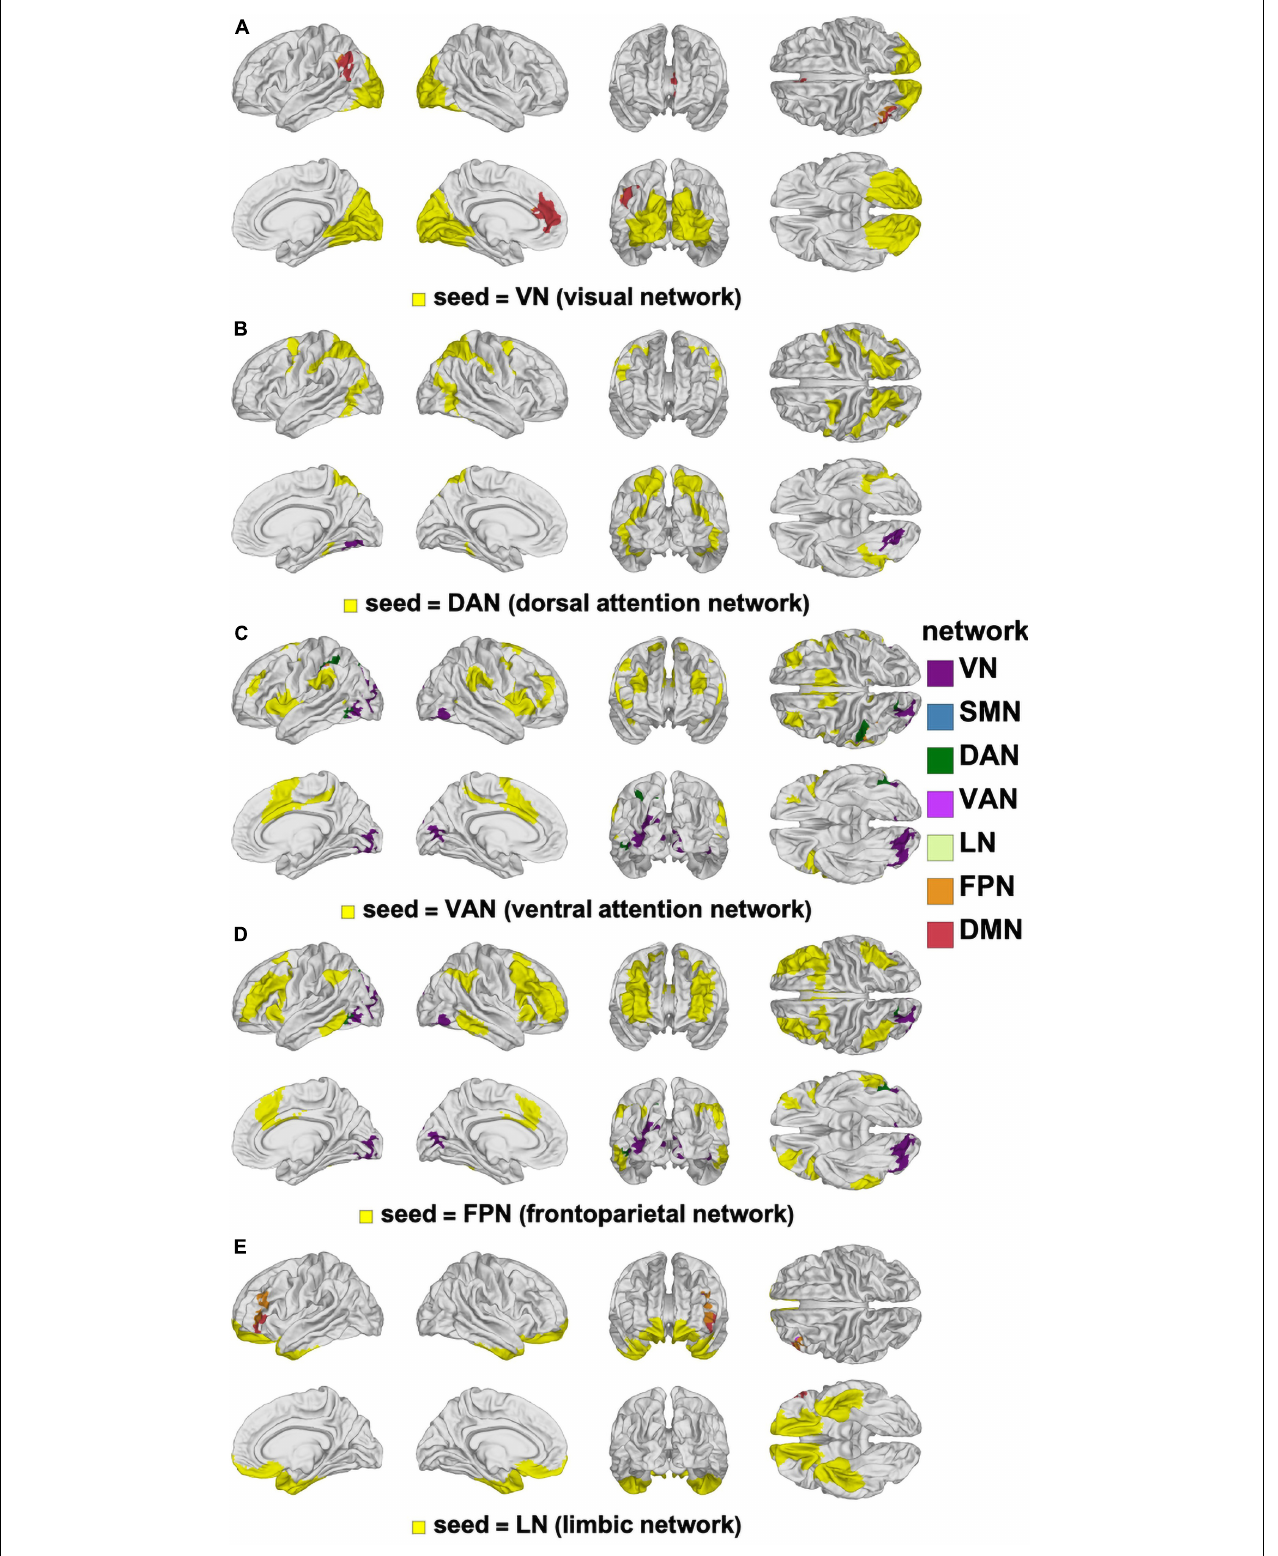
FIGURE 8 | Canonical RSNs (seeds, yellow) and corresponding cortical clusters whose FC with the corresponding seed network changes significantly according to the age-by-sex interaction. The seed RSNs are the VN (A) , DAN (B) , VAN (C) , FPN (D) , and LN (E) . DAN, dorsal attention network; FPN, frontal parietal network; FC, functional correlation; LN, limbic network; RSN, resting state network; VAN, ventral attention network; VN, visual network.